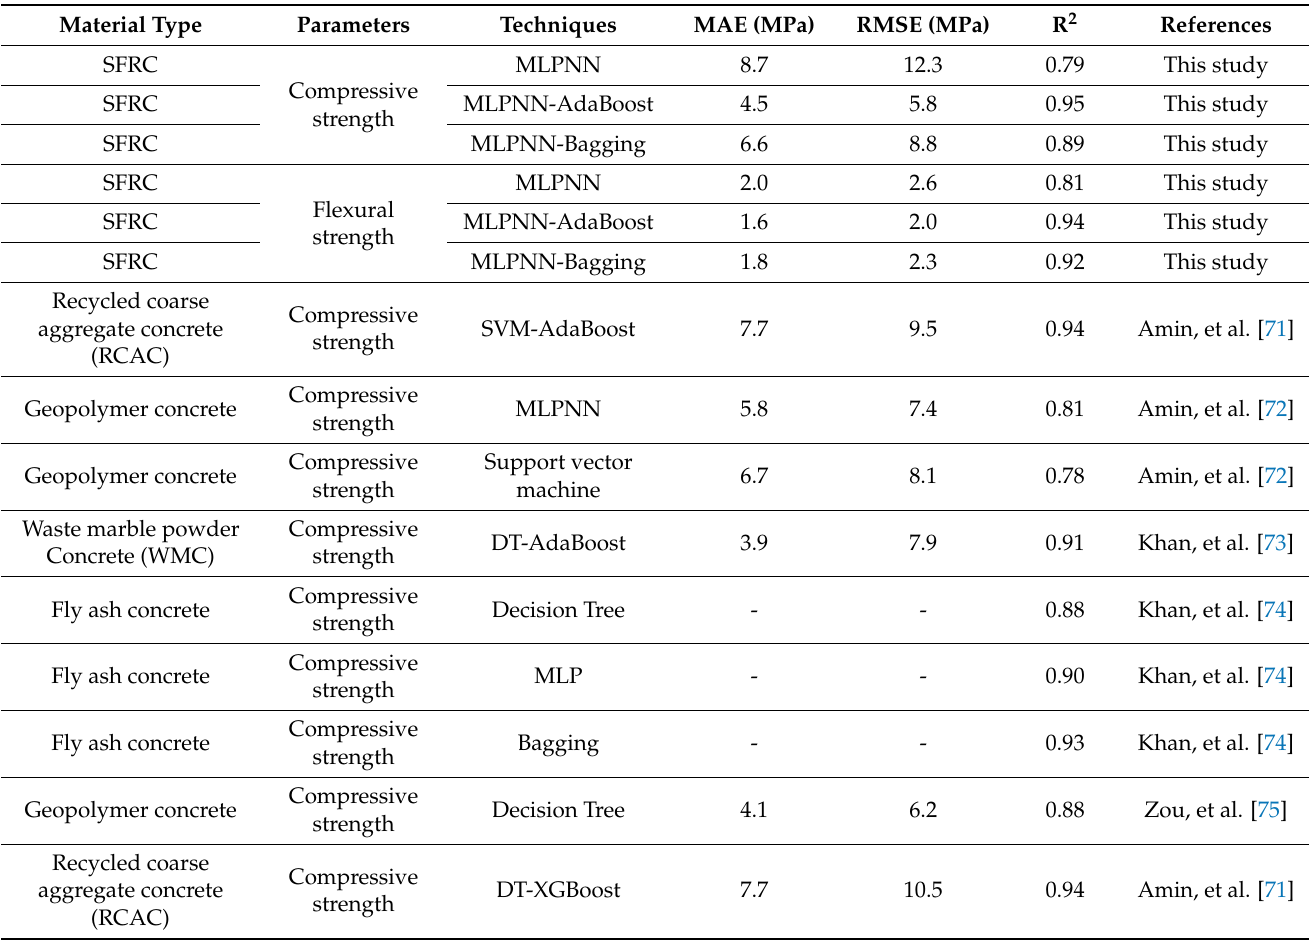
Table 3. Statistical checks of comparison of this study with the